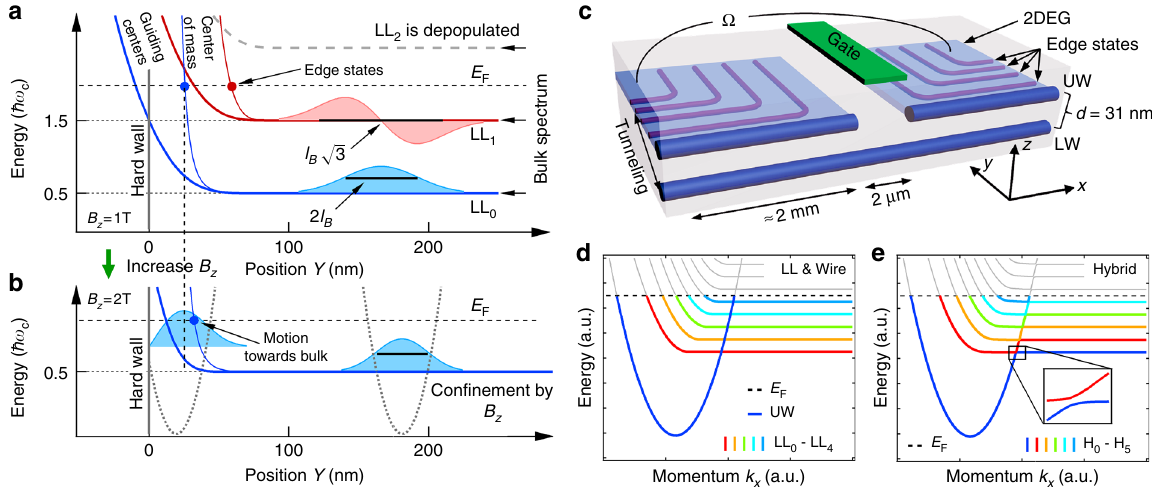
Fig. 1 Bulk to edge correspondence. a Energy evolution of the center of mass (CM) position (thin blue/red curves) and the guiding center (GC) position (bold blue/red curves) for the fi rst two Landau levels LL 0 and LL 1 . Here, LL 2 is above the Fermi energy and is depopulated. The con fi nement (hard wall) lifts the bulk LLs in energy, resulting in corresponding edge states (solid circles) when the CM is crossing the Fermi energy E F . Note that the Fermi energy shown here is lower than in the experiment. b Same as a for larger magnetic fi eld B z , where the width 2 σ n = 2 l B depopulated, with magnetic length l B . c Coordinate system (black) and sample schematic, showing the 2DEG in light blue, upper and lower quantum wire (UW/LW) in dark blue, top gate in green, and CM for integer quantum Hall edge states in purple. Ω indicates the conductance measurement. d Simpli fi ed UW and LL dispersions calculated for independent triangular and hard wall con fi nement. e Calculated dispersion for the combined con fi nement potential, resulting in hybridized states H n with avoided crossings (see inset). Here, the bulk LL 0 transforms into the UW mode at the sample edge. Gray segments indicate empty states, colored ones are fi